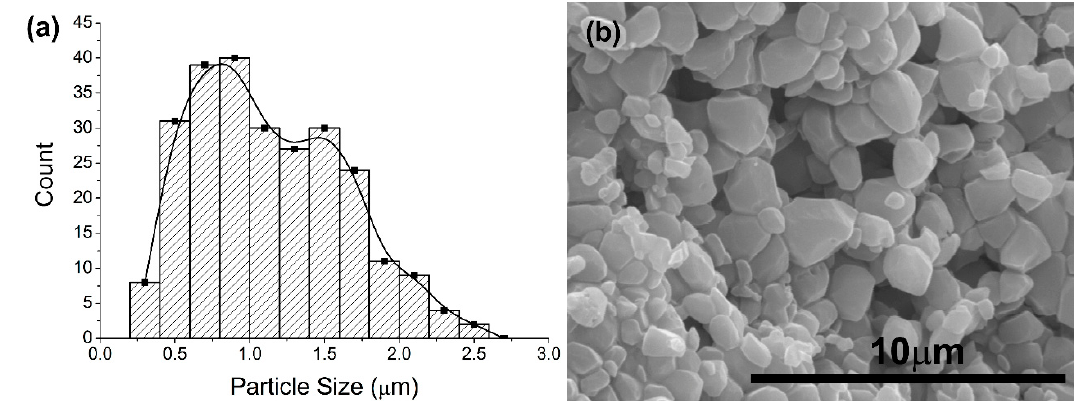
Figure 7. Biphasic scaffolds (50HA/50 β‐ TCP) obtained with 40 wt.% of slurry solid content and 1200 °C. ( a ) Histogram of grain size. ( b ) Micrographs of the structure.